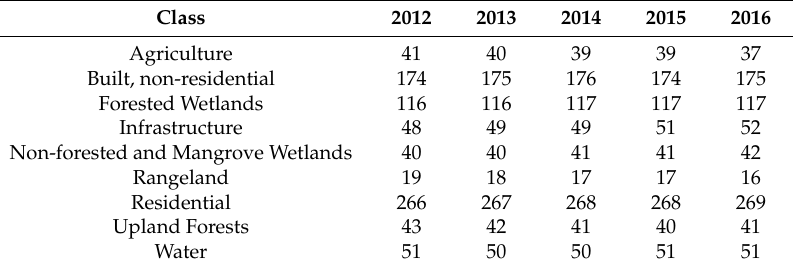
Table 7. Estimated land requirements of LULC classes (km 2 ) for each simulated